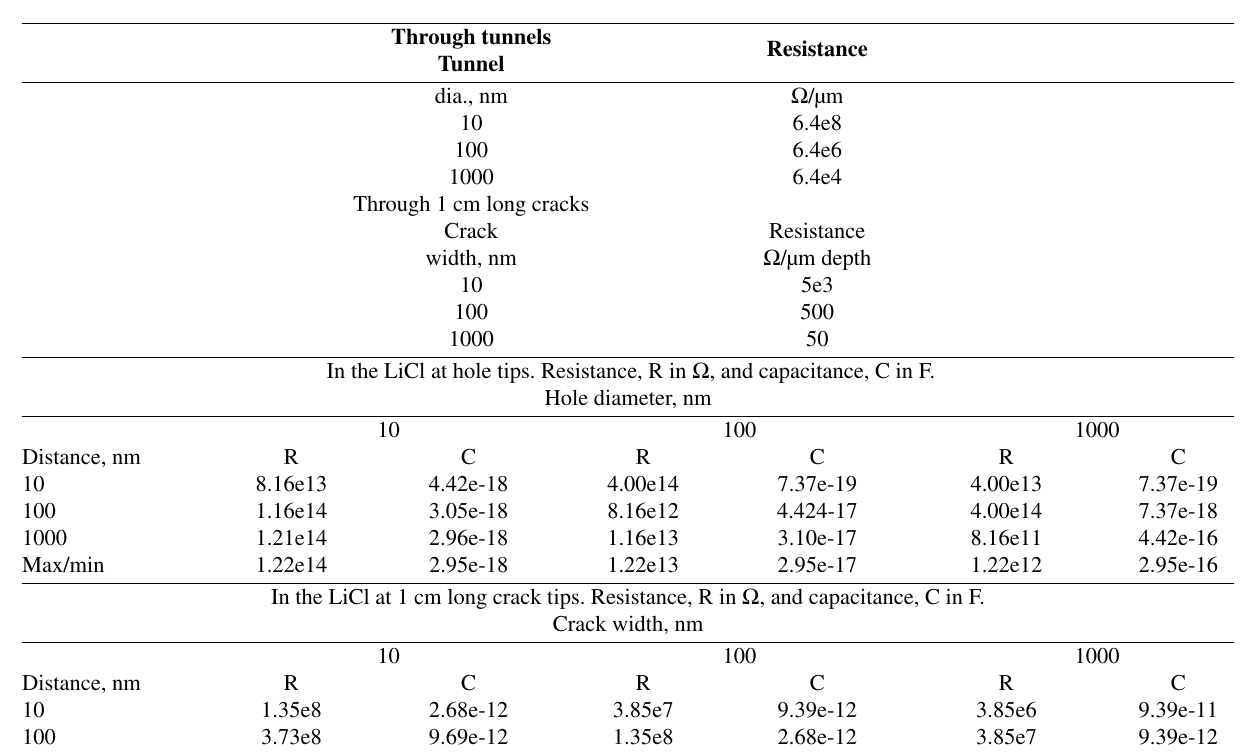
Table 7. Examples of calculated resistance through catholyte filled tunnels and cracks filled with 1.8M LiAlCl LiCl at hole and crack tips.